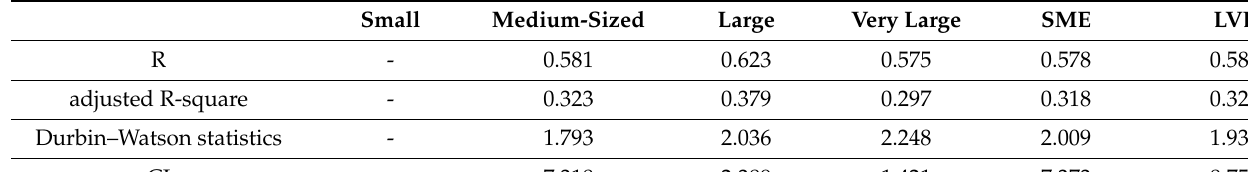
Table 13. Model summary for the Czech Republic. Small Medium-Sized